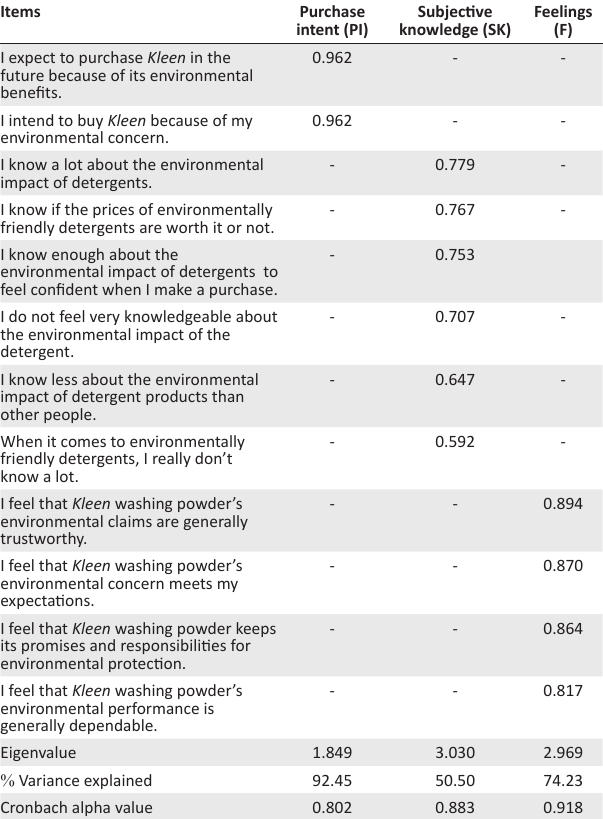
TABLE 1: Construct validity check of scale adaptations.